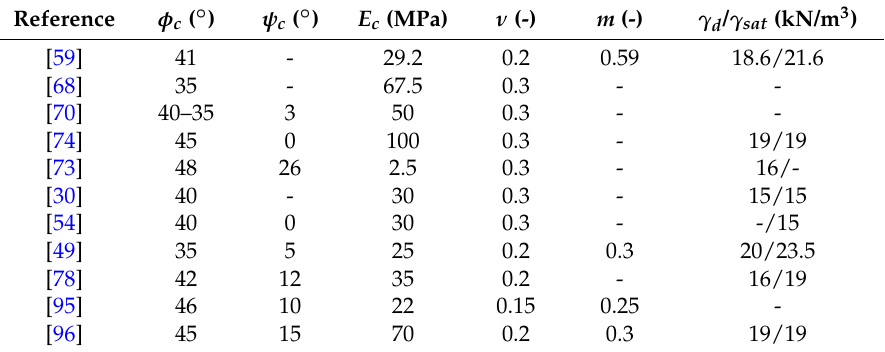
Table 3. Parameters used to model stone columns in numerical analyses.